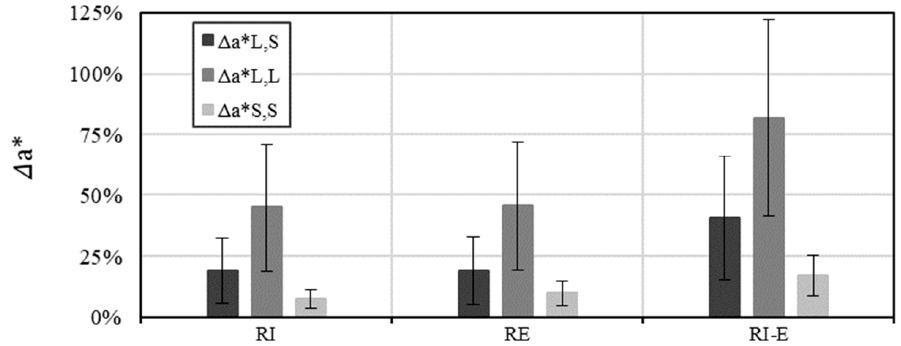
Figure 20. Percentage ∆ a * increment ± standard deviation of (RI), (RE) and (RI-E) buttressed arches, classified according to the variation of the activated mechanisms with respect to the (UN) buttressed arches.